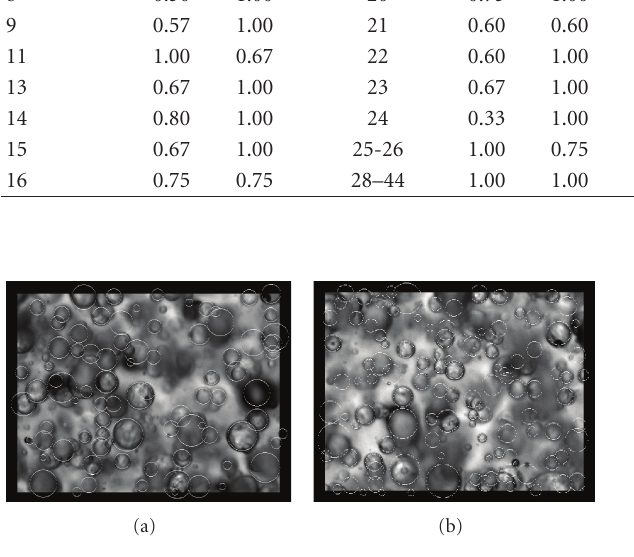
Figure 8: The drops detected by our program. Each detected drop is marked with a white circle on top of the original image.